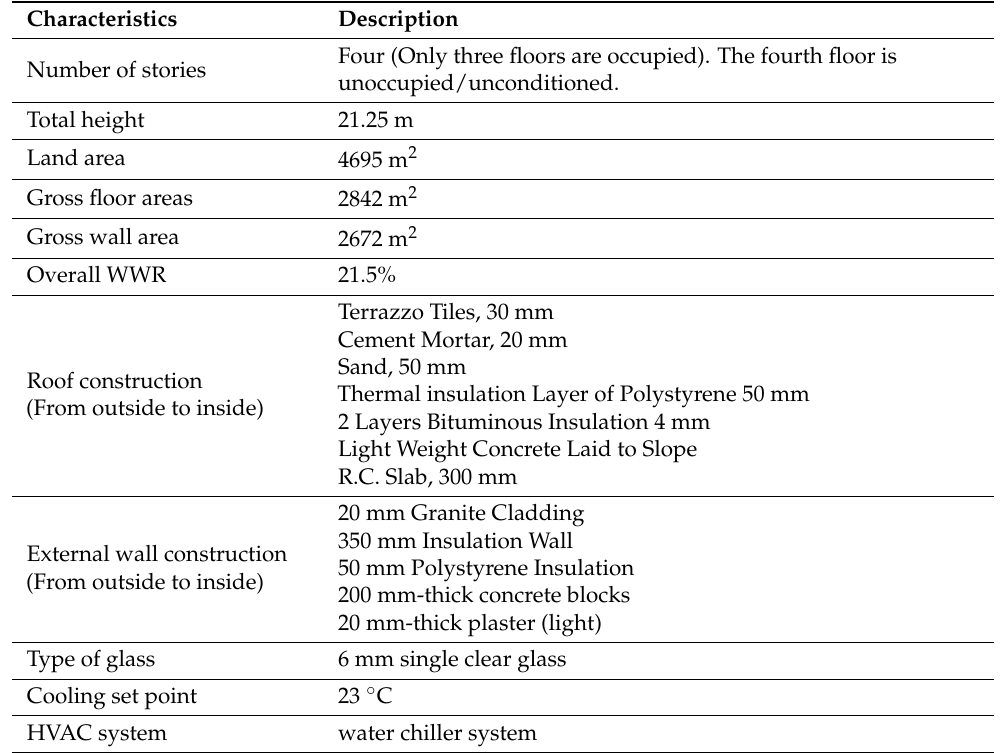
Table 2. Building construction, HVAC, and lighting systems characteristics of the ADF